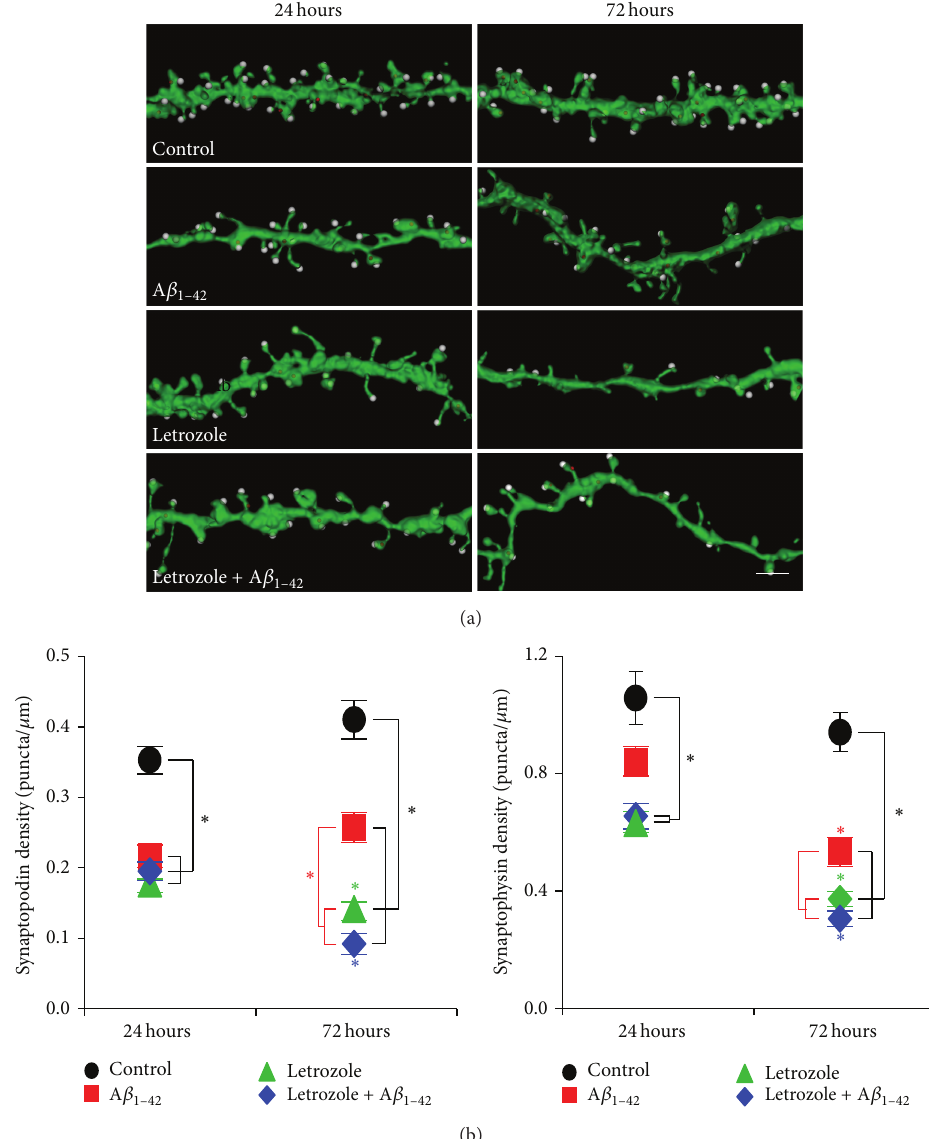
Figure 5: Letrozole and 𝐴𝛽 1 reduce synaptic proteins. (a) Representative 3D reconstructions of dendritic segments from sister cultures that – 42 (1 𝜇 M), and letrozole (1 𝜇 m) or 𝐴𝛽 1 + letrozole (1 𝜇 m) for 24 or 72 hours and immunostained for were treated with either control, 𝐴𝛽 1 – 42 – 42 synaptophysin (white) and synaptopodin (red). Scale bar, 2 𝜇 m. (b) Quantification of the densities of synaptopodin-positive puncta following , letrozole or 𝐴𝛽 1 + letrozole treatments treatments. There is a significant decrease in synaptopodin puncta after 24 and 72 hours of 𝐴𝛽 1 – 42 – 42 +letrozole- comparedtocontrolconditions.After72hours,thenumberofsynaptopodinpunctawassignificantlylowerinletrozoleand 𝐴𝛽 1 – 42 alone. When synaptopodin puncta densities were compared between 24- and 72-hour treated cultures treated cultures compared to 𝐴𝛽 1 – 42 + letrozole-treated cultures after 72 hours. 24 hours: control, n = total dendritic there was a significant decrease only in letrozole and 𝐴𝛽 1 – 42 , 𝑛 = 633 𝜇 m of dendrite from 8 cells in 4 cultures; letrozole, 𝑛 = 952 𝜇 m of segment lengths of 1041 𝜇 m from 12 cells in 4 cultures; 𝐴𝛽 1 – 42 + letrozole, 𝑛 = 1007 𝜇 m of dendrite from 10 cells in 4 cultures. 72 hours: control, 𝑛 = total dendritic dendrite from 10 cells in 4 cultures; 𝐴𝛽 1 – 42 , 𝑛 = 472 𝜇 m of dendrite from 9 cells in 4 cultures; letrozole, 𝑛 = 838 𝜇 m of segment lengths of 559 𝜇 m from 10 cells in 3 cultures; 𝐴𝛽 1 – 42 + letrozole, 𝑛 = 750 𝜇 m of dendrite from 8 cells in 4 cultures. There is a significant decrease in dendrite from 9 cells in 4 cultures; 𝐴𝛽 1 – 42 , letrozole, or 𝐴𝛽 1 + letrozole treatments compared to control conditions. After 72 synaptophysin puncta after 24 and 72 hours of 𝐴𝛽 1 – 42 – 42 + letrozole-treated cultures compared to 𝐴𝛽 1 hours, the number of synaptophysin puncta was significantly lower in letrozole and 𝐴𝛽 1 – 42 – 42 alone When synaptophysin puncta densities were compared between 24- and 72-hour treated cultures there was a significant decrease in